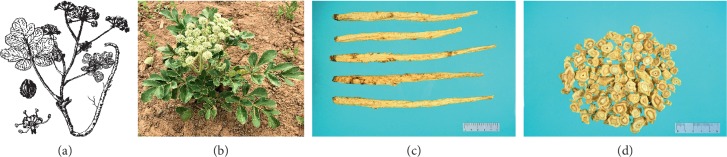
Images of G. littoralis from Chinese Materia Medica Dictionary (a), the whole plant of G. littoralis, including the flower of G. littoralis, fruit of G. littoralis, and flowering G. littoralis (b), dried roots of G. littoralis (c), and sliced roots of G. littoralis (d).